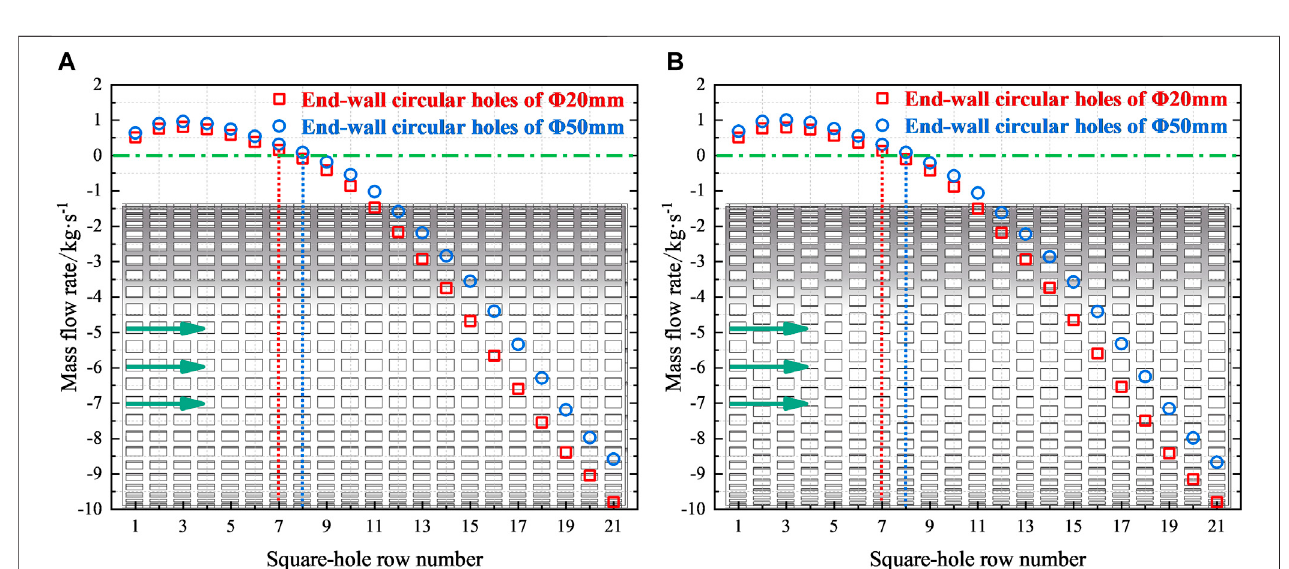
FIGURE 9 | Flow distribution characteristics of fl ow homogenizers with UASHs. (A) Inline arrangement (Nos. 4 and 5). (B) Staggered arrangement (Nos. 8 and 9).